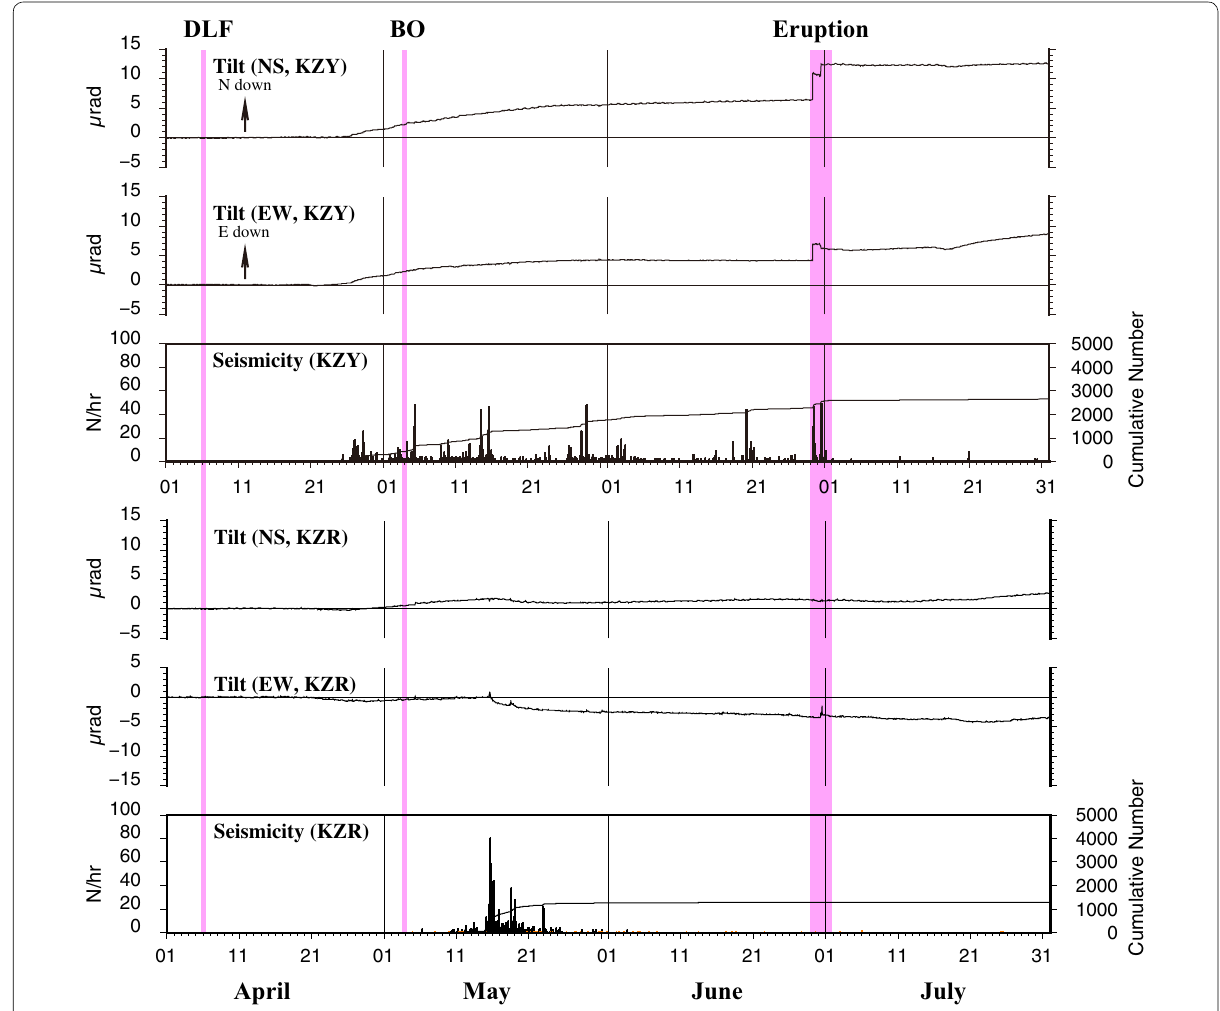
Fig. 7 Tilt changes (NS and EW components) and seismicity from tiltmeters in Kozukayama (KZY) and Kojiri (KZR). Timings of the initial swarm of the deep low-frequency event (DLF), blowout of the No. 39 SPW (BO) and the eruption are also shown. Seismicity here indicates hourly number of earthquakes within circles shown in Fig. 6. In KZY, seismicity and tilt change are evident in late-April to mid-May and on eruption days. In KZR, both increase in